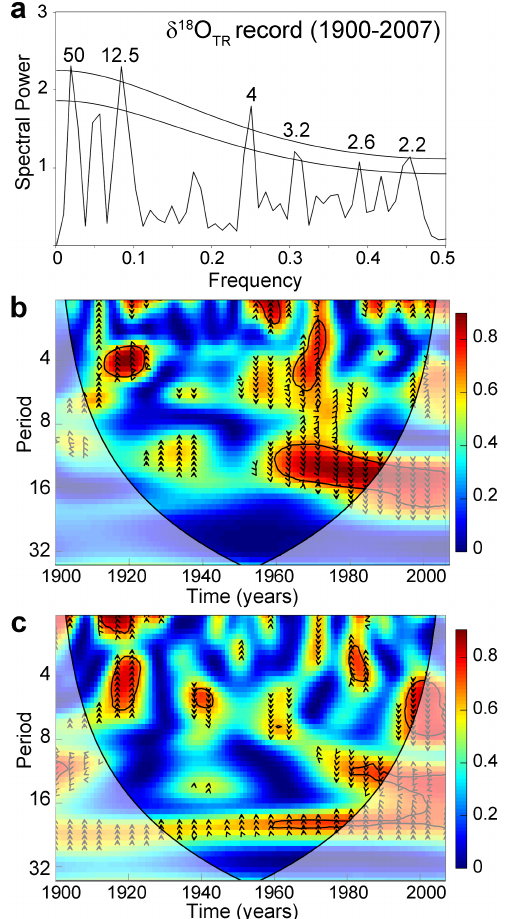
Figure 4. (a) Spectral analysis (Schulz and Mudelsee, 2002) of the δ 18 O TR chronology from 1900–2007. 90 and 95% confidence levels are indicated. (b) Wavelet coherence transform comparing shared variance as a function of frequency between δ 18 O TR record and Warm Pool (WP) ENSO index (Jan n + 1 ) and (c) Cold Tongue (CT) ENSO index (Jan n + 1 ) for 1900–2007. The wavelet coherence illustrating temporal frequency coherence between the time series at given periods. The thick black contour designates where time series share significant coherence ( p = 95%) and the cone of influence where edge effects might distort the picture is shown as a lighter shade. Arrows indicate the phase relationship between series with in-phase pointing right and antiphase pointing